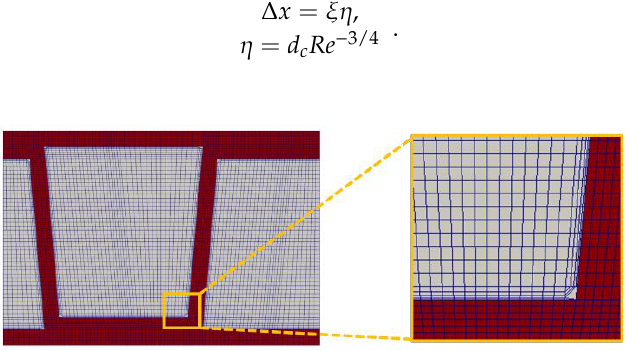
Figure 7. Offset-strip fins turbulator: Detail of the two regions mesh adopted for the calculations at the micro-scale.